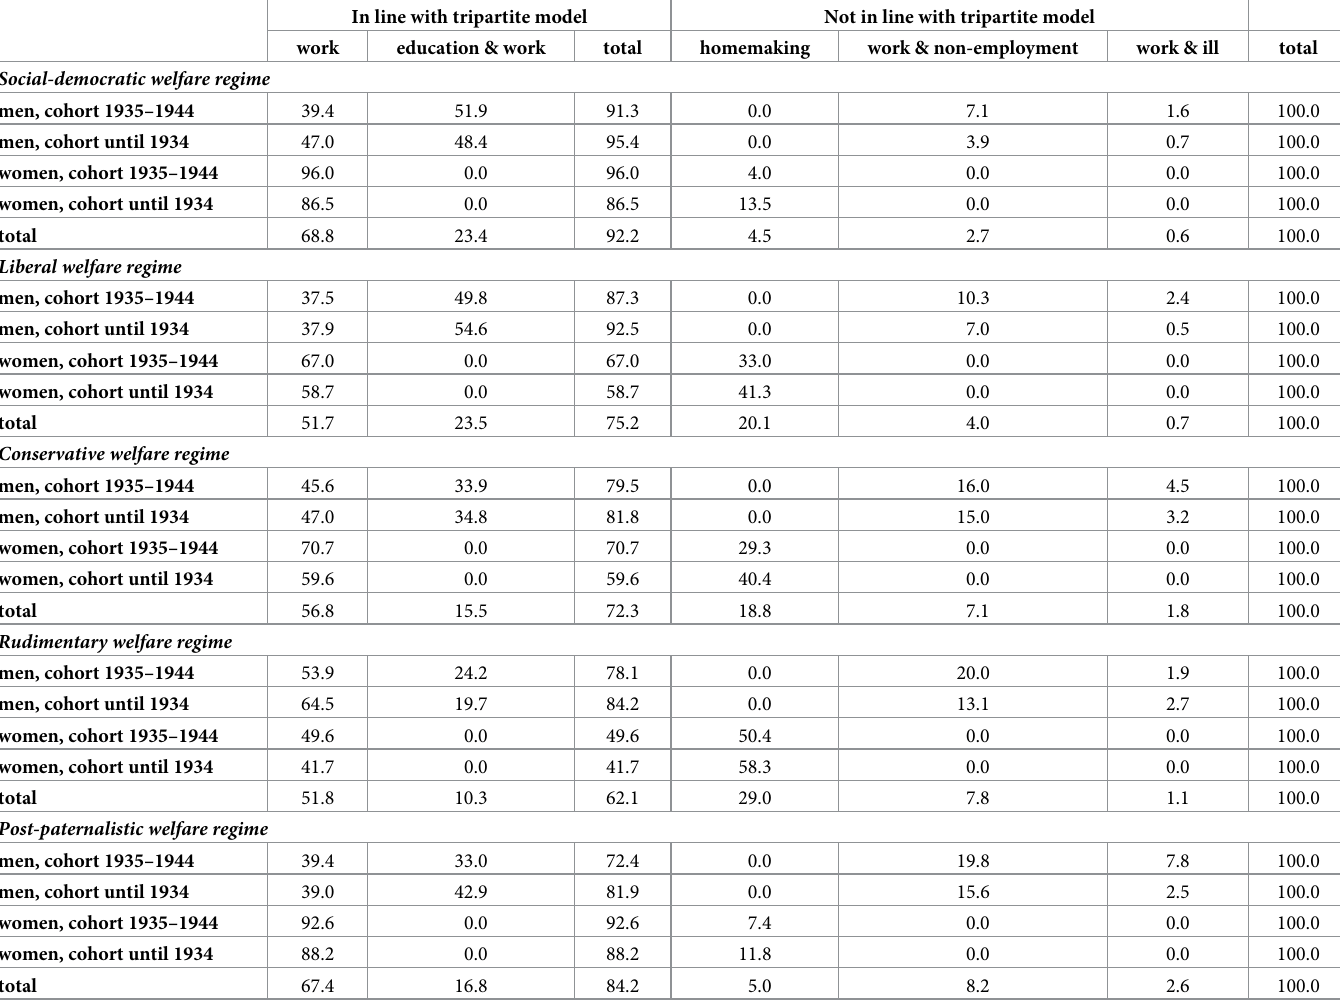
Table 5. Within-country differences in working age life-course clusters, by welfare regime (in percent). In line with tripartite